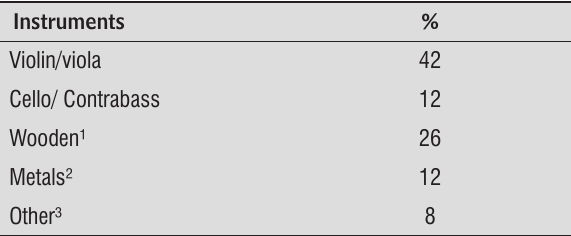
Table 4 - Percentage of instrumentalists by type of